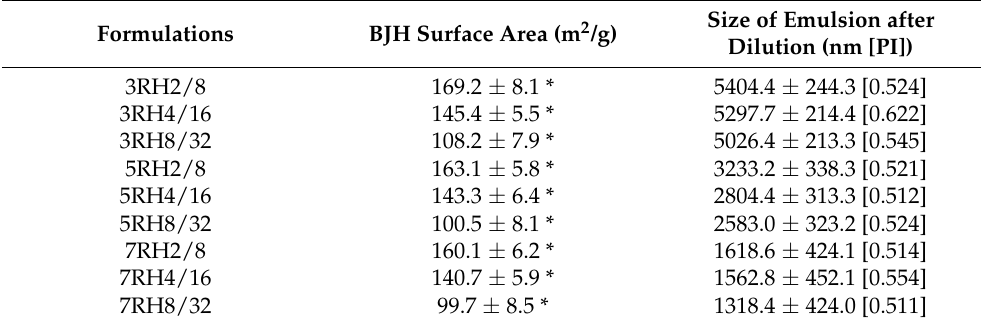
Table 3. Surface areas and droplet diameters of the dry medium internal-phase emulsions (dry MIPEs) after dilution. Formulations BJH Surface Area (m 2